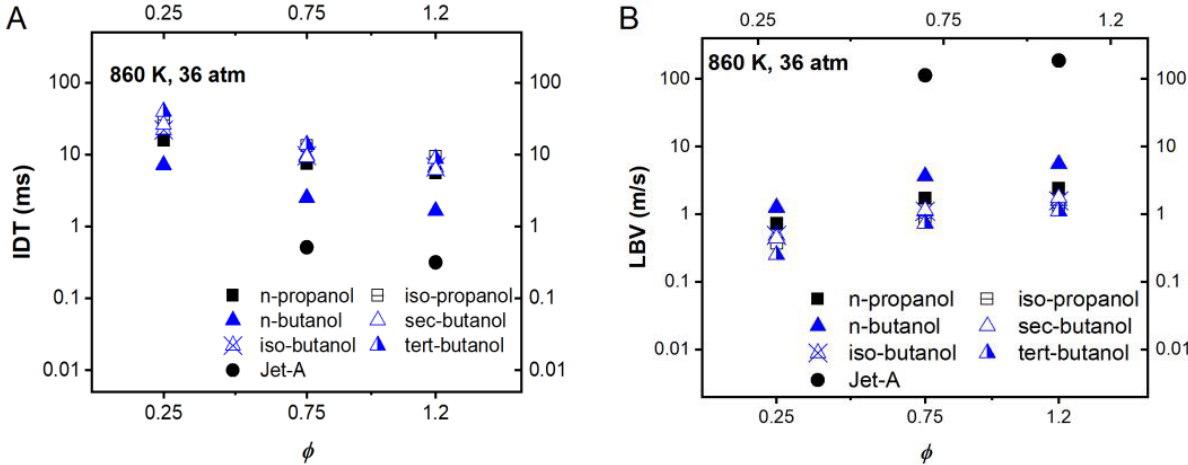
Figure 13. Model prediction for ( A ) IDT and ( B ) LBV of the propanol and butanol isomers, and the Jet-A surrogate at 860 K, 36 atm and equivalence ratios of 0.25, 0.75, and 1.2.